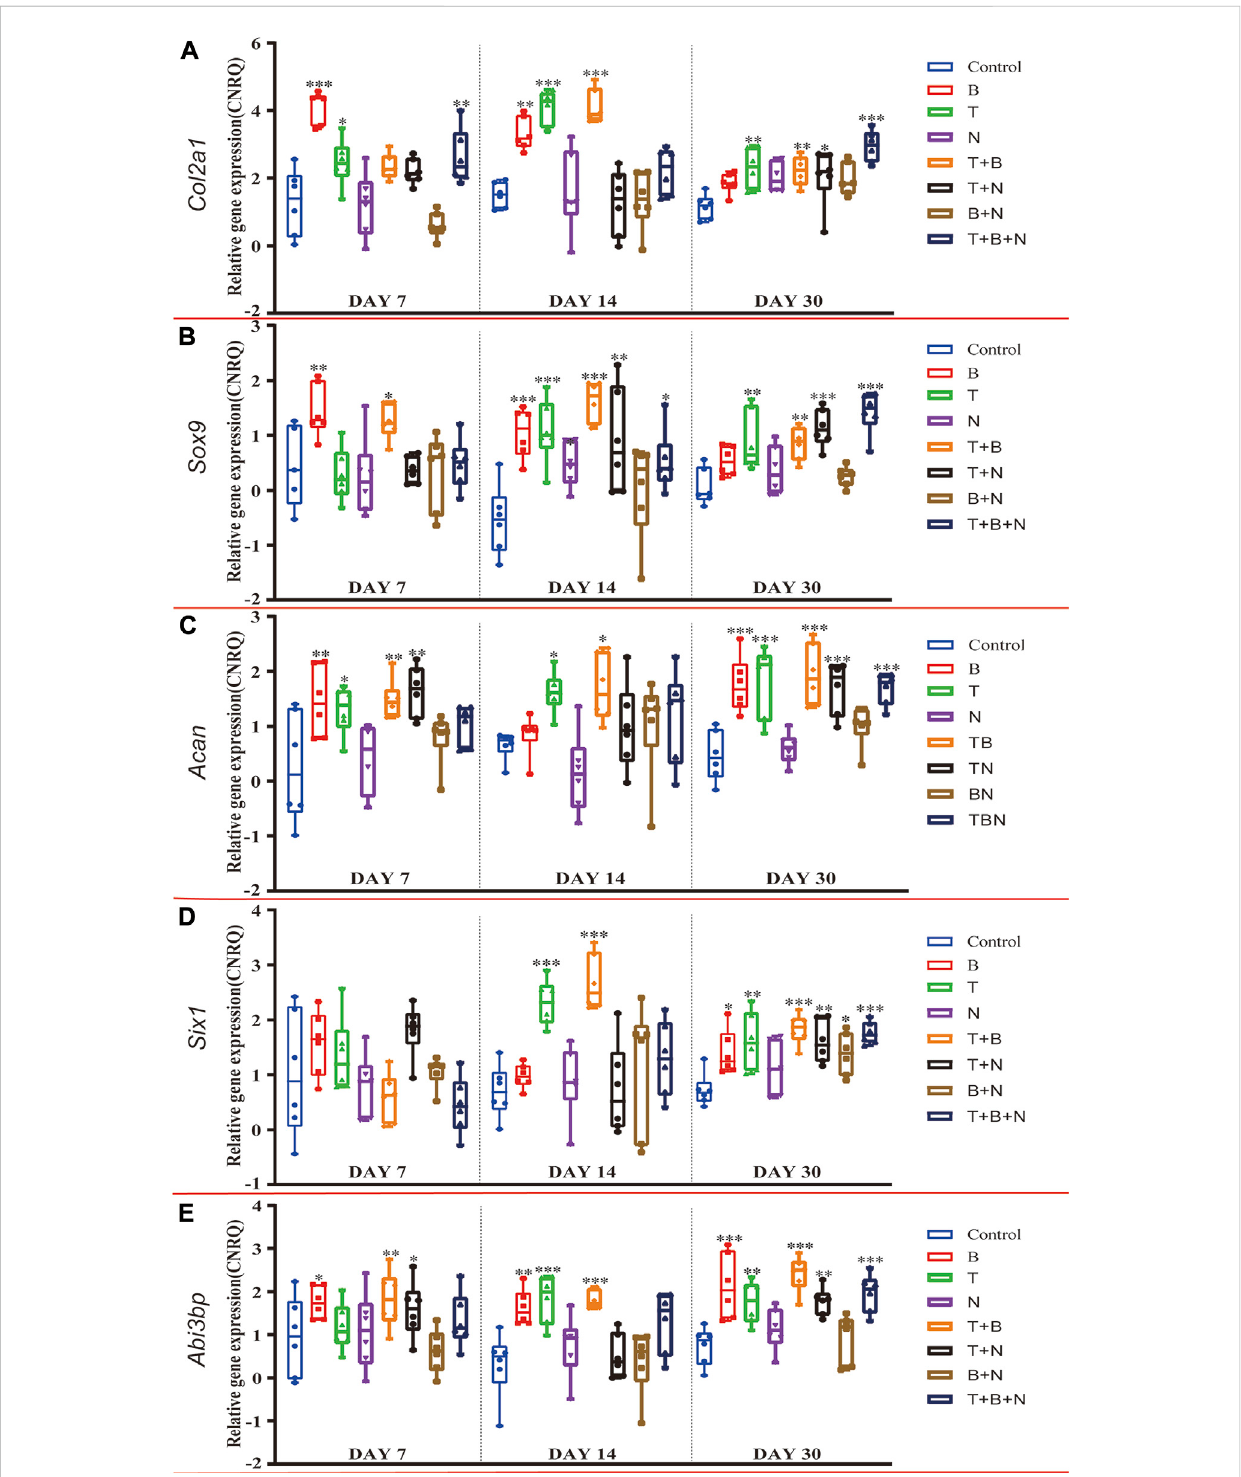
FIGURE 1 Therelativegeneexpressionof (A) Col2a1 , (B) Sox9 , (C) Acan , (D) Six1 and (E) Abi3bp at7,14,and30 days,whichwereshownasCNRQ.Theasterisks indicate that the stimulated group is statistically signi fi cant compared to the control group. The baseline number 0 indicates non-cultured fresh tissue was used as the normalization parameter. (n = 6; * p < 0.05; ** p < 0.01; *** p <